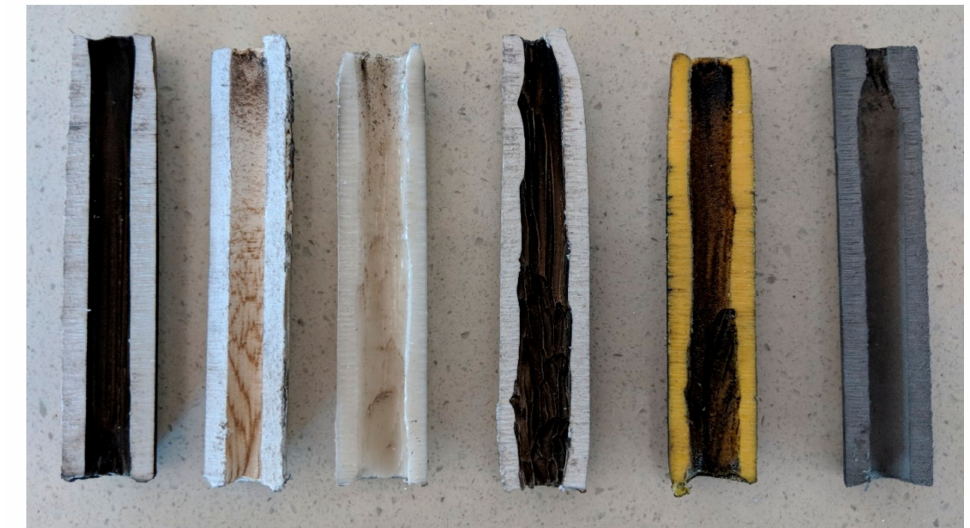
Figure 5. Cross section of each di ff erent small-scale fuel grain, left to right: ABS, PLA, PP, ASA, PTEG, and